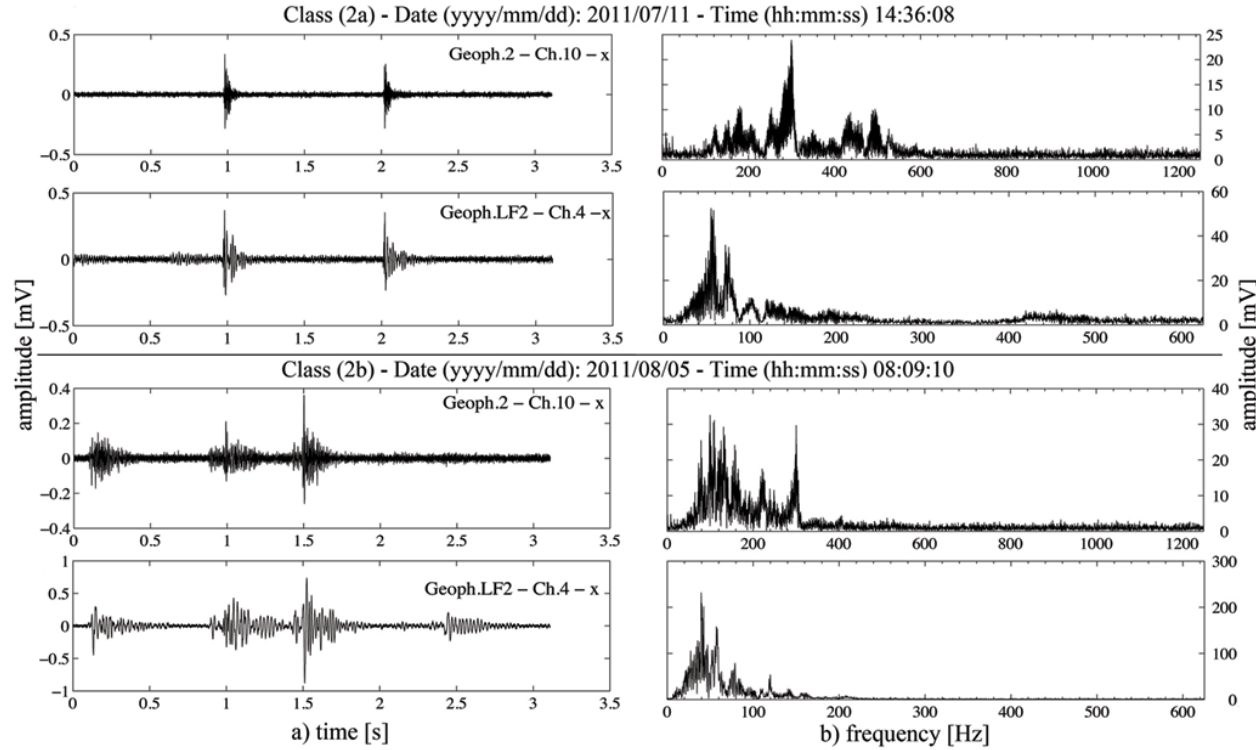
Fig. 10. Characteristics of the two classes of multiple events: example of a signal recorded by an HF and a LF geophone (a) in the time domain and (b) in the frequency